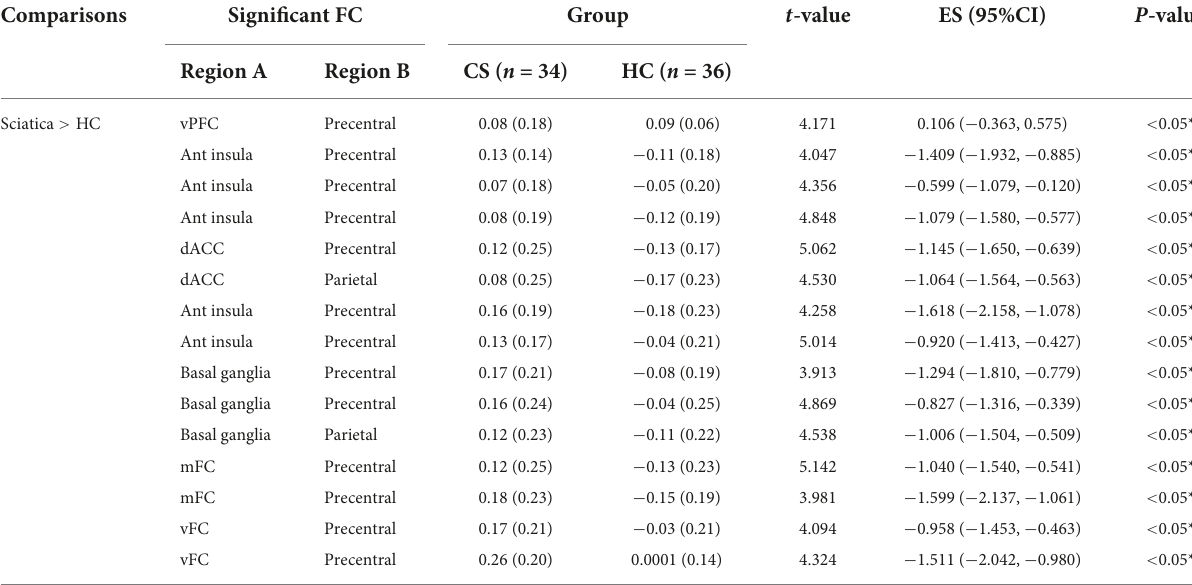
TABLE 4 The comparison of FCs between two groups.